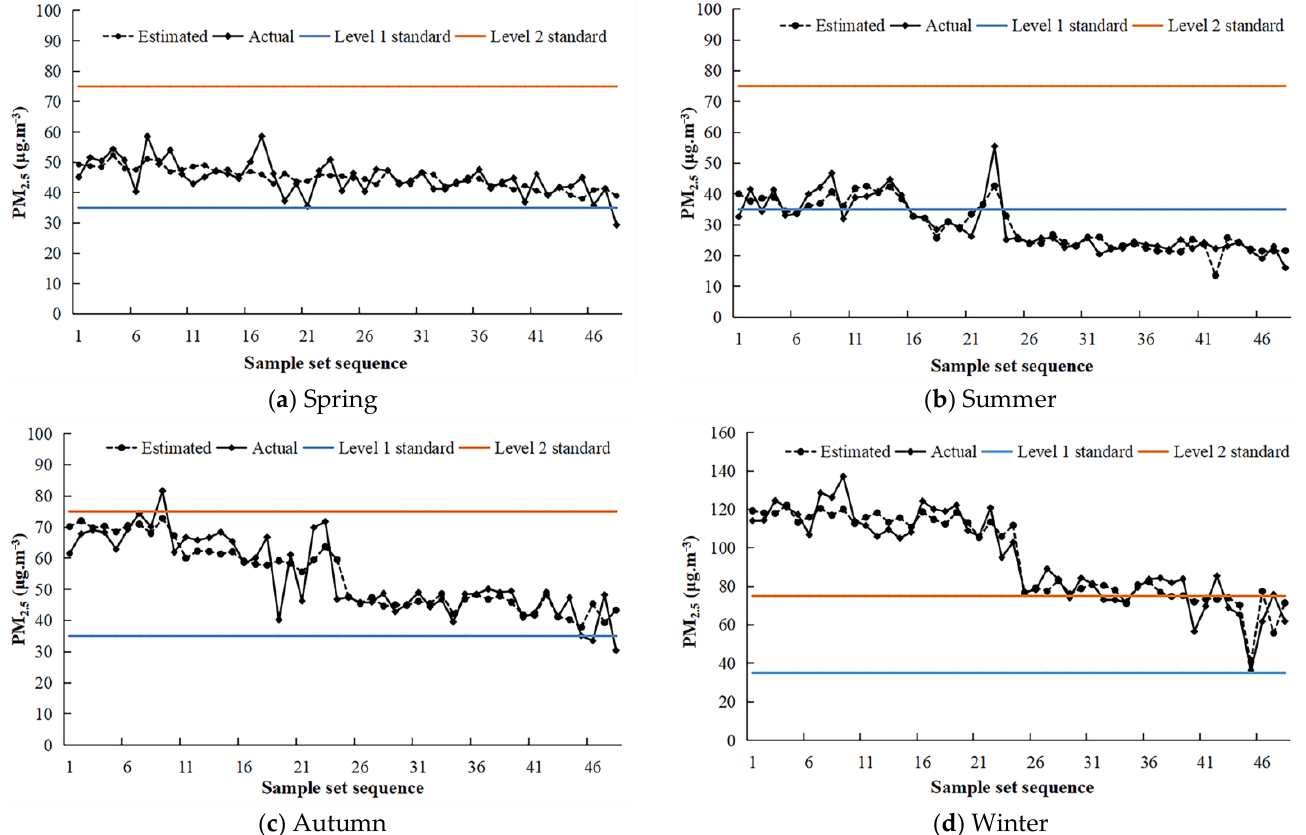
Figure 6. Comparison of the estimated and measured PM 2.5 concentrations, given the sample set sequence. The blue line represents the Level 1 standard, and the orange line represents the Level 2 standard. The Level 1 standard refers to the 24-h average PM 2.5 concentration lower than 35 µ g · m − 3 . The Level 2 standard refers to the 24-h average PM 2.5 concentration lower than 75 µ g · m − 3 .